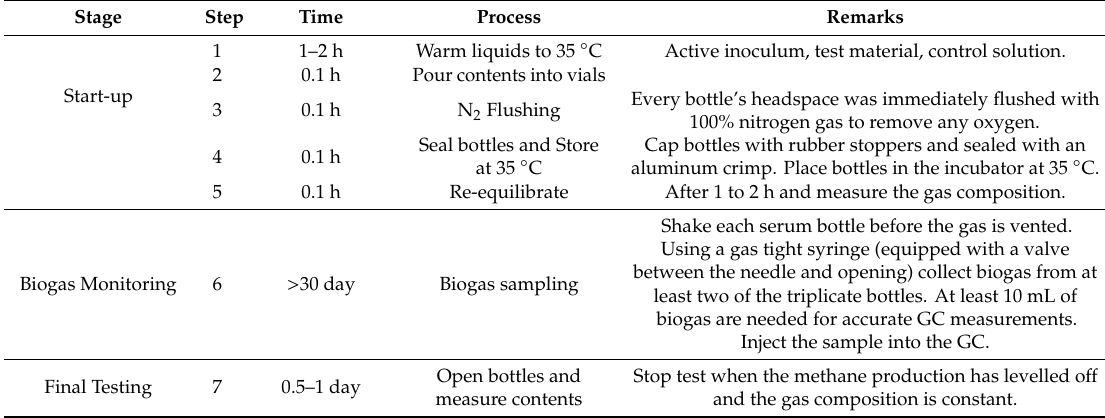
Table 6. Execution stages and steps for manual operation of BMP serum bottle